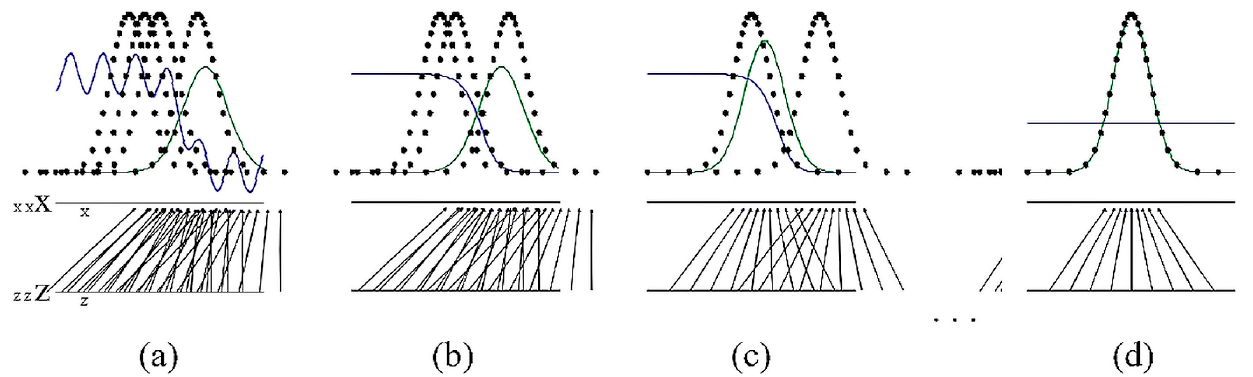
. Figure 2c Learning from the gradient of the